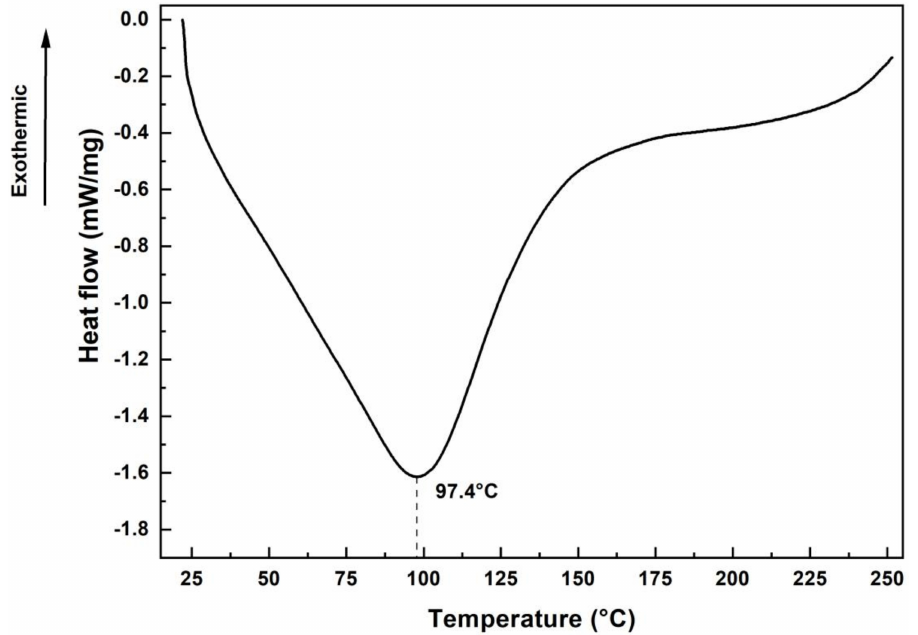
Figure 6. DSC curve of the sedge